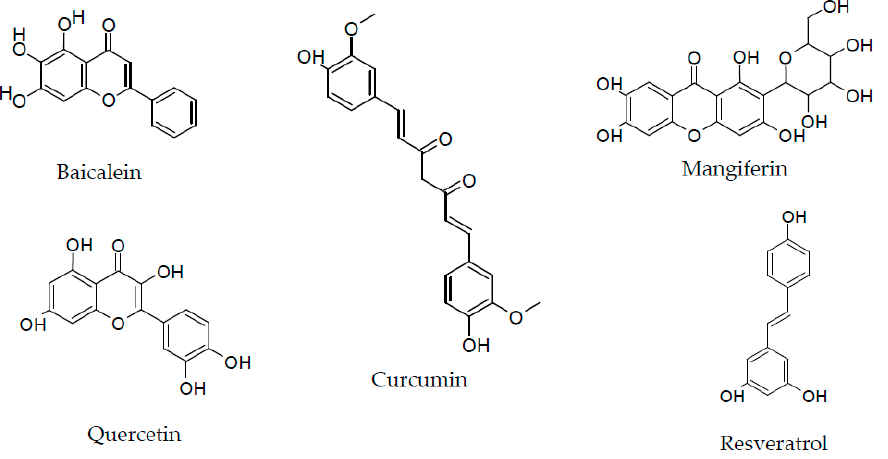
Figure 1. Chemical structure of the considered polyphenols.